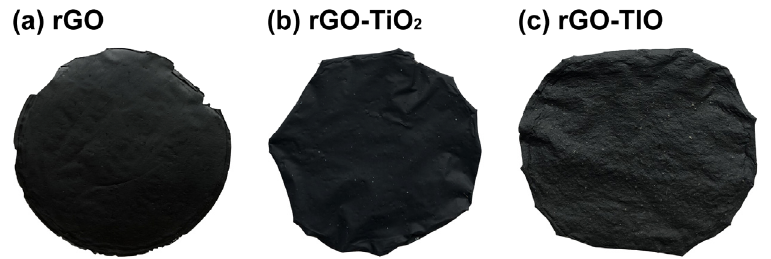
Figure 4. Pictures of the produced membranes: ( a ) rGO, ( b ) rGO–TiO 2 , and ( c ) rGO–TIO. The morphology and composition of the membranes were tested by SEM-EDX analysis (Figure 5).